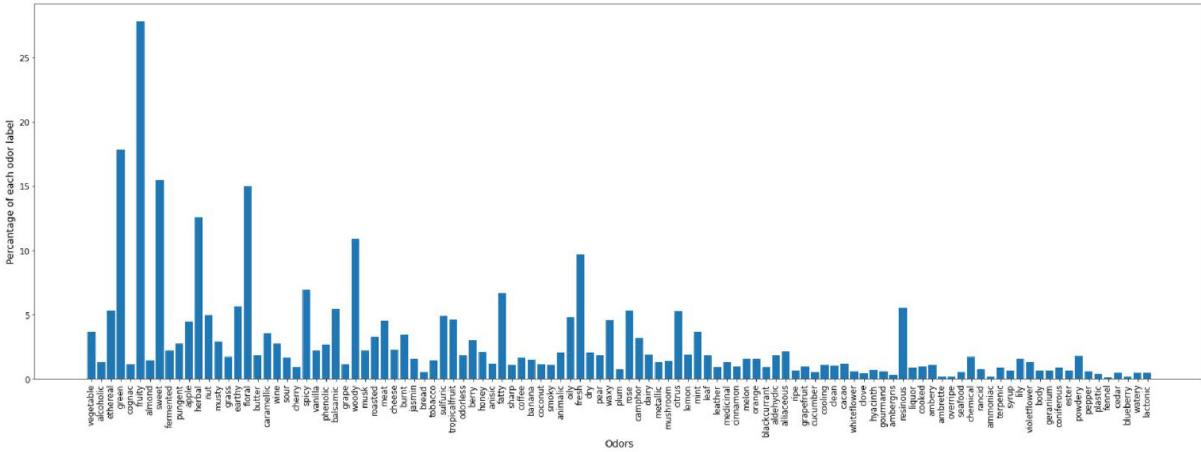
Figure 5. Label imbalance with the fruity label occurring approximately 27% of the time as opposed to fennel occurring less than 1% times in our data.